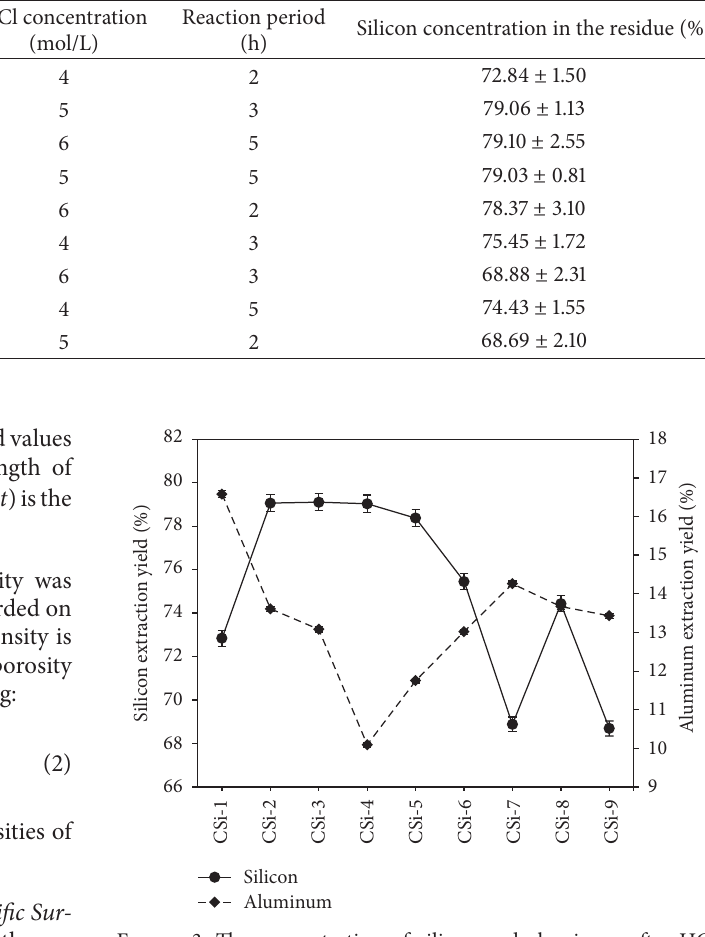
Figure 3: The concentration of silicon and aluminum after HCl